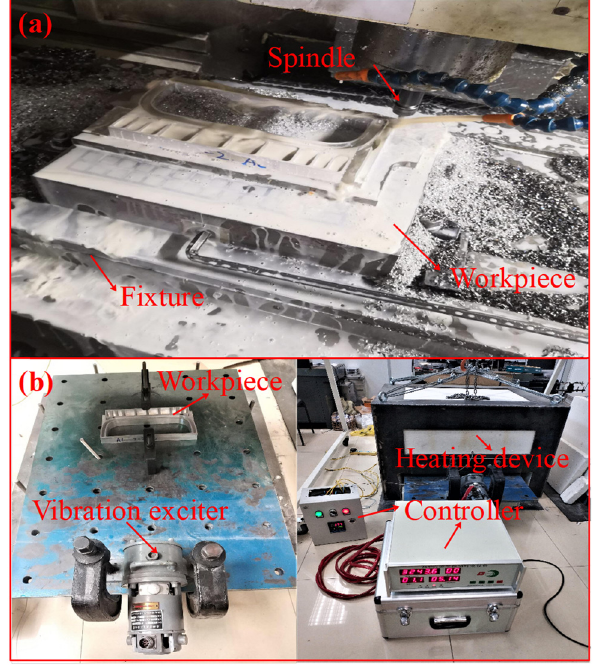
Figure 5: ( a ) Machining experiments and ( b ) TVSR platform.